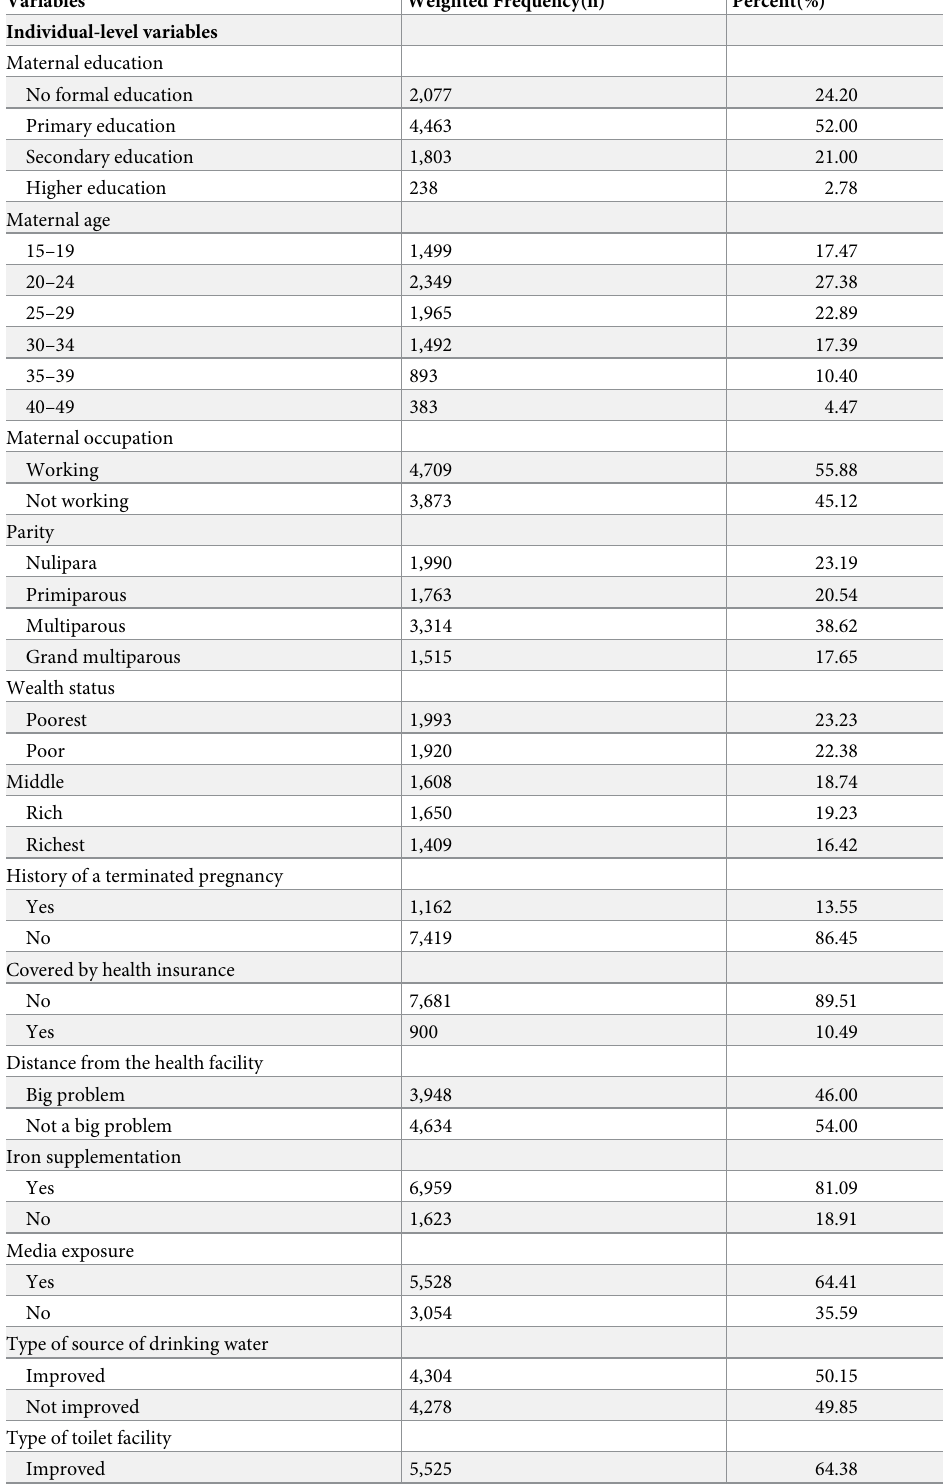
Table 2. The sociodemographic characteristics of study participants, East